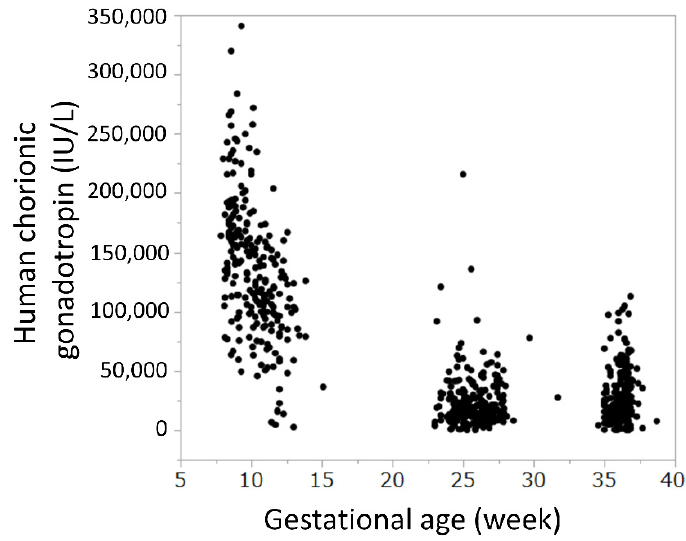
Figure 3. Serum human chorionic gonadotropin levels during pregnancy.